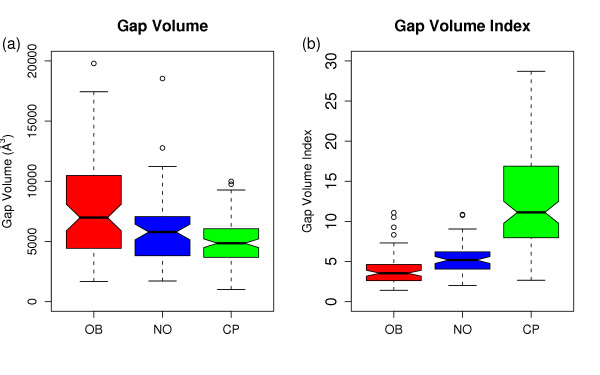
Boxplot of gap volumes (a) and gap volume indices (b) of the BNCP-CS dataset.